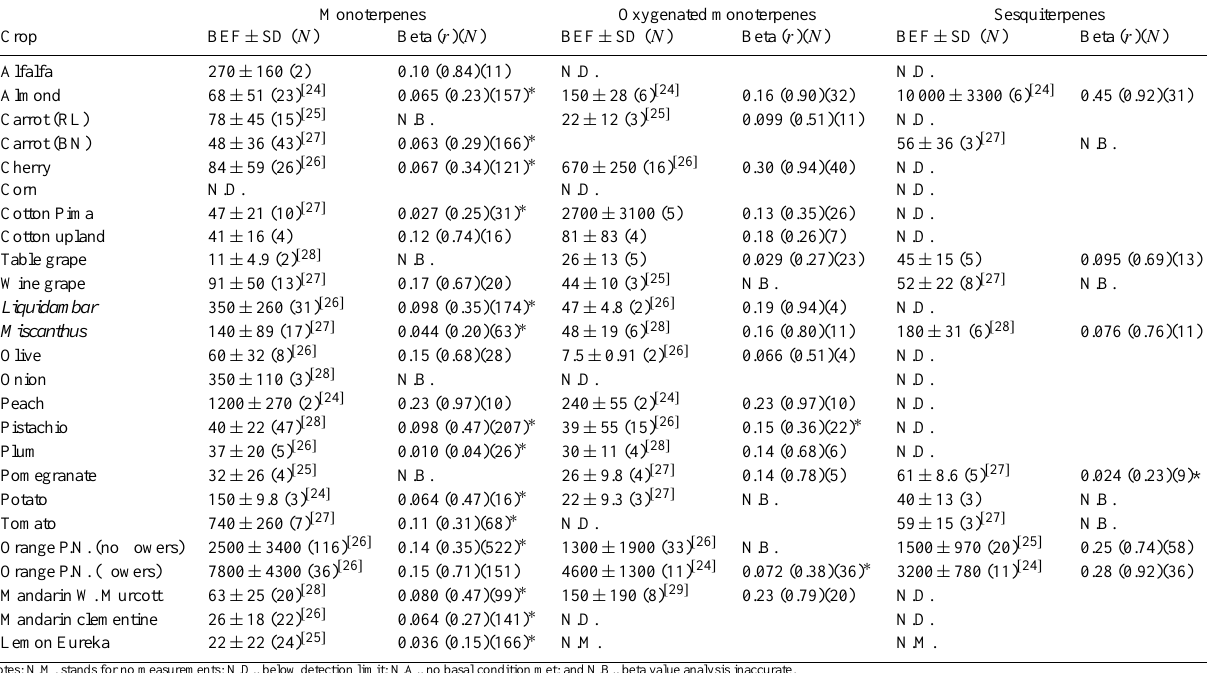
Table 2. Basal emission factors (ngC gDM − 1 h − 1 ) and beta values for monoterpenes, oxygenated monoterpenes, and sesquiterpenes from enclosure studies ( N is the sample size and r the correlation